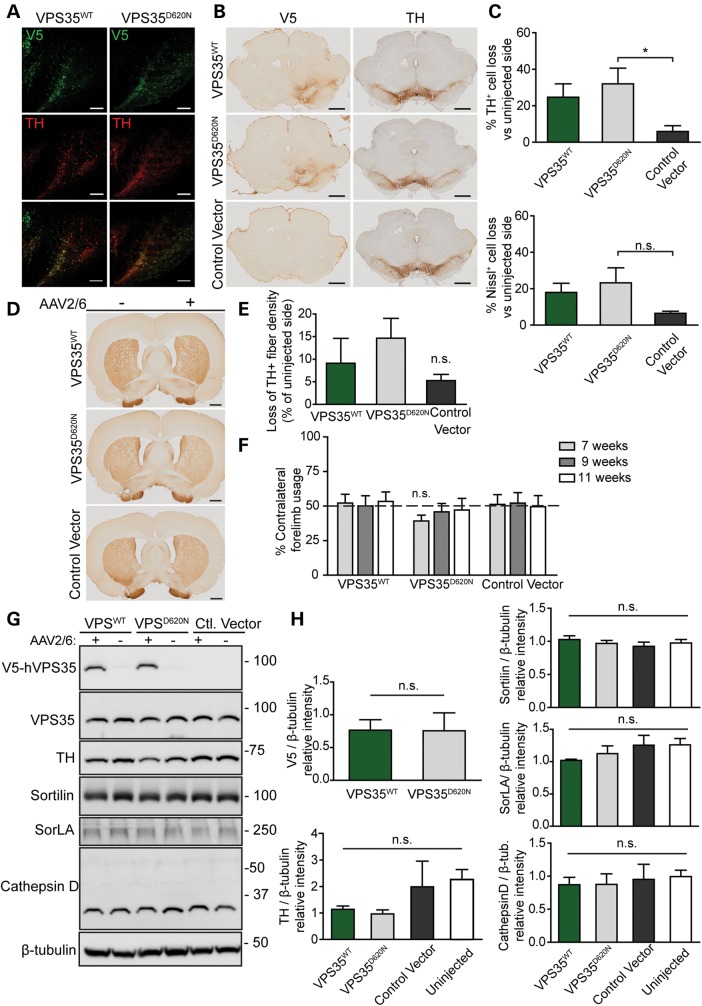
Dopaminergic neuronal degeneration induced by AAV2/6-mediated expression of D620N VPS35 in the substantia nigra of adult rats. (A) Photomicrographs showing immunofluorescent co-labeling of substantia nigra with anti-V5 and anti-TH antibodies indicating the equivalent expression of V5-tagged human VPS35WT and VPS35D620N proteins within dopaminergic neurons at 12 weeks following stereotactic injection of AAV2/6 vectors. Scale bar: 200 μm. (B) Representative photomicrographs of anti-V5 and anti-TH immunohistochemical analysis in adjacent sections of rat substantia nigra at 12 weeks following the stereotactic injection of AAV2/6 vectors expressing human VPS35WT and VPS35D620N or a control vector. V5 labeling in the substantia nigra is accompanied by a decrease in TH immunostaining. Scale bar: 1 mm. (C) Stereological analysis of TH-positive dopaminergic or total Nissl-positive neurons in the substantia nigra expressed as percent cell loss relative to the contralateral uninjected nigra. Bars represent mean ± SEM (n = 6 animals/group). *P<0.05 by one-way ANOVA with Dunnett's post hoc analysis. n.s., non-significant. (D) Representative photomicrographs of immunostaining for TH-positive nerve terminal in the striatum at 12 weeks following AAV2/6 delivery. Scale bar: 1 mm. (E) Quantitation of optical density of TH immunostaining in the striatum. Data are expressed as percent loss of TH-positive fibers relative to the contralateral uninjected side. Bars represent the mean ± SEM (n ≥ 4 animals/group). Data were assessed by one-way ANOVA with Dunnett's post hoc analysis. (F) Cylinder asymmetry test performed at 7, 9 and 11 weeks postsurgery assessing forelimb contacts with the cylinder wall over a 5 min period. Forelimb use contralateral to the injected nigra is expressed as a percent of total forelimb contacts (left + right) on the cylinder wall. Dashed line indicates the expected forelimb usage under normal conditions. Bars represent mean ± SEM (n = 8 animals/group). Data were assessed by one-way ANOVA with Newman–Keuls post hoc analysis. (G) Western blot analysis of soluble extracts from ventral midbrain at 12 weeks following stereotactic injection of rats with AAV2/6 vectors, separated into ipsilateral (+) and contralateral (−) hemispheres. Blots were probed with antibodies to V5, VPS35, TH, sortilin, SorLA and cathepsin D, with β-tubulin as a loading control. Molecular masses are indicated in kDa. (H) Densitometric analysis of V5, TH, sortilin, SorLA or cathepsin D levels normalized to β-tubulin levels on blots containing ventral midbrain extracts. Bars represent mean ± SEM (n = 3–4 animals/group). Data were analyzed by one-way ANOVA with Newman–Keuls post hoc analysis for multiple comparisons, or by unpaired, two-tailed Student's t-test for pair-wise comparisons, as indicated. n.s., non-significant.